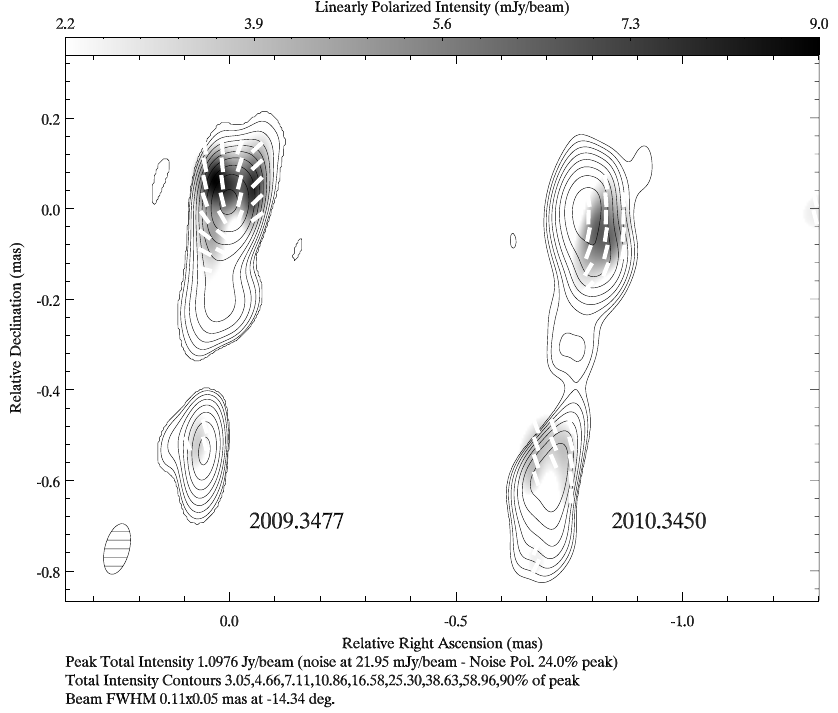
Figure 3. Sequence of two GMVA images at 86 GHz obtained with GMVA during 2008 and 2009. Contours show total intensity, grey scale represents the linearly polarized intensity, and the short white sticks indicate the electric vector position angle distribution. A common convolving beam, as shown in the lower-left corner of the plot, was used for all